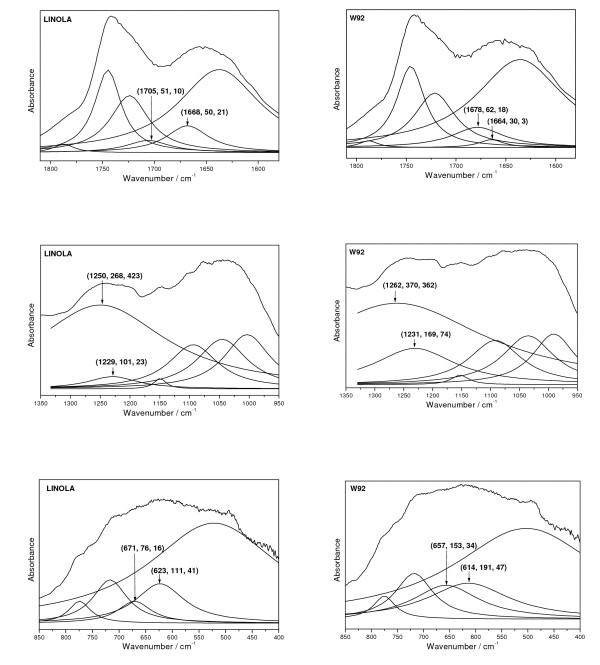
The deconvolution of the IR contours of control and transgenic (W92) seedcakes extracts. The deconvolution of the IR contours of control and transgenic (W92) seedcakes extracts in the regions: 1580 - 1800, 950 - 1350 and 400 - 850 cm-1 into Lorenz components. The energetic positions, of the components with differ for the GM and natural flax are given in the parentheses. The 1678 cm-1 band assigned to coumaric acid, 1261 cm-1 band assigned to SECO, 1273 cm-1 to SDG and 1277 cm-1 and 657 cm-1 bands assigned to ferulic acid, and 614 cm-1 that correspond to the bands observed in the region of SDG, kaempferol, coumaric and ferulic acids.